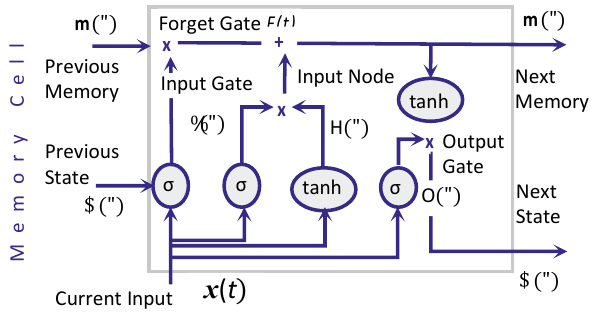
Figure 5. The structure of the memory cell adopted in the bi-directional LSTM neural network